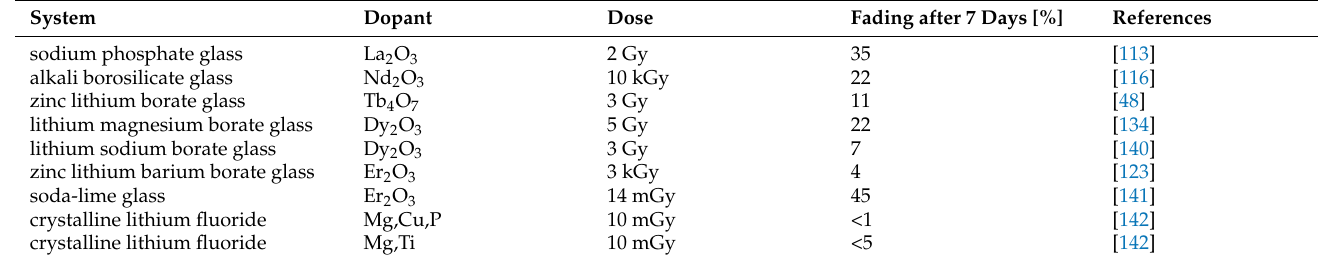
Figure 5. The ranges of rare-earth dopant concentration for various glass systems data. The legend’s markings correspond to the concentration that induces the maximum luminescence signal for a given glass [48,114 – 123,134,140,141]. Table 2. Thermal fading for various glass and glass-ceramics systems.